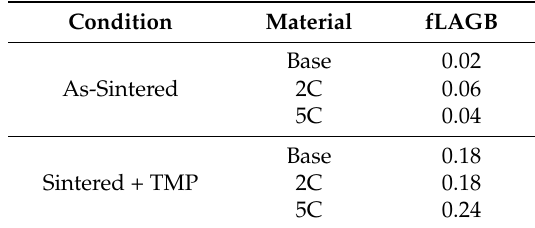
Table 2. Fraction of low angle grain boundaries (misorientation ≤ 15°) in the microstructures presented in Figure 4.